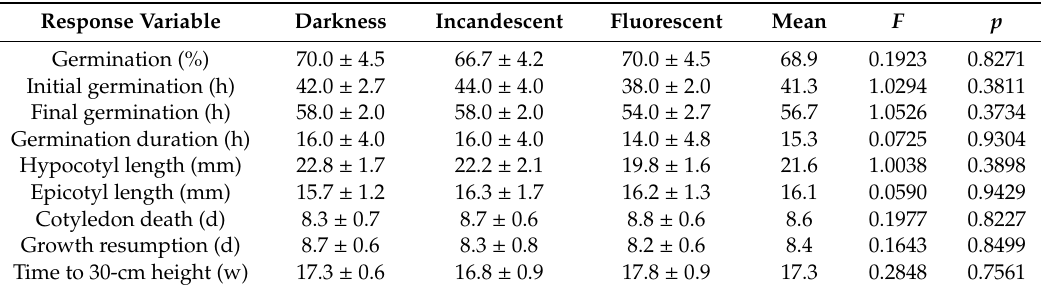
Table 1. The influence of exposing germinating Serianthes nelsonii seeds to darkness or light of 60 µ mol / m 2 / s as low red:far red light (0.7; incandescent bulb) or high red:far red light (4.8; fluorescent bulb) on germination and seedling traits. Mean ± standard error. Six replications, five seeds each.